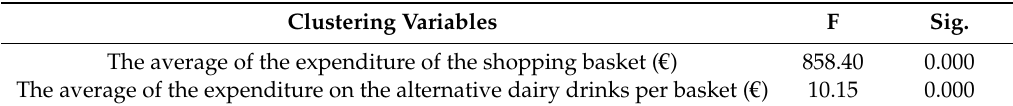
Table 4. ANOVA table for three-cluster solution. Clustering Variables F